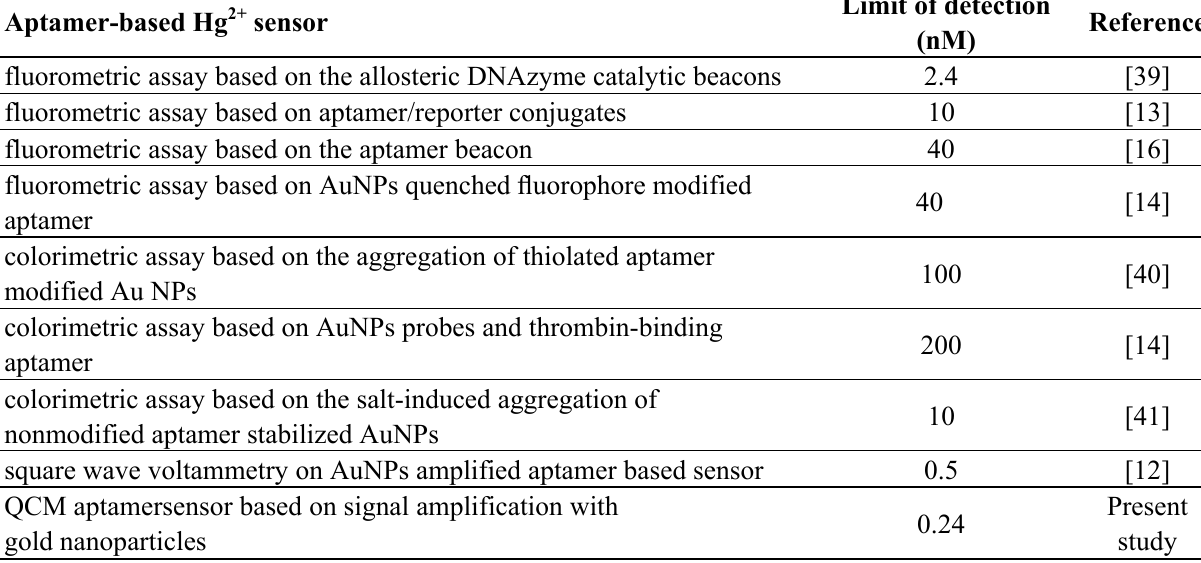
Table 1. Comparison of the sensitivity of different Hg 2+